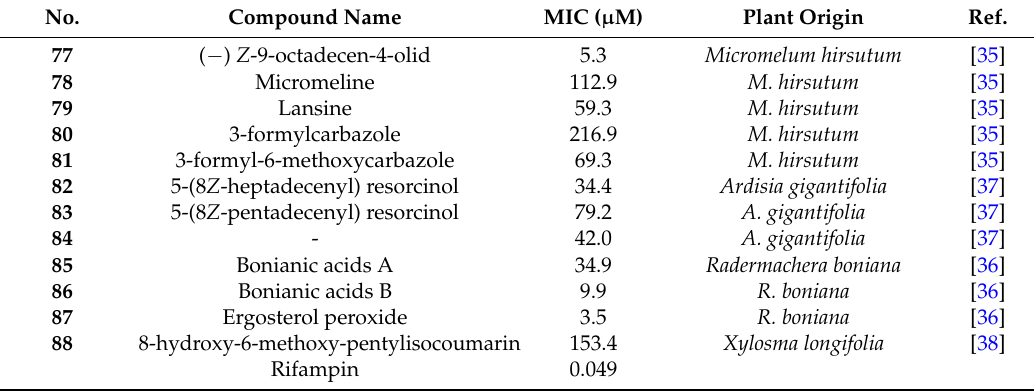
Table 3. The anti-TB activity of compounds 77 – 88